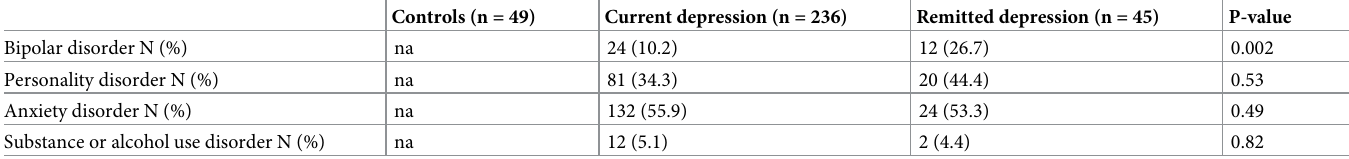
Table 3. Psychiatric comorbidity in patients with current and remitted